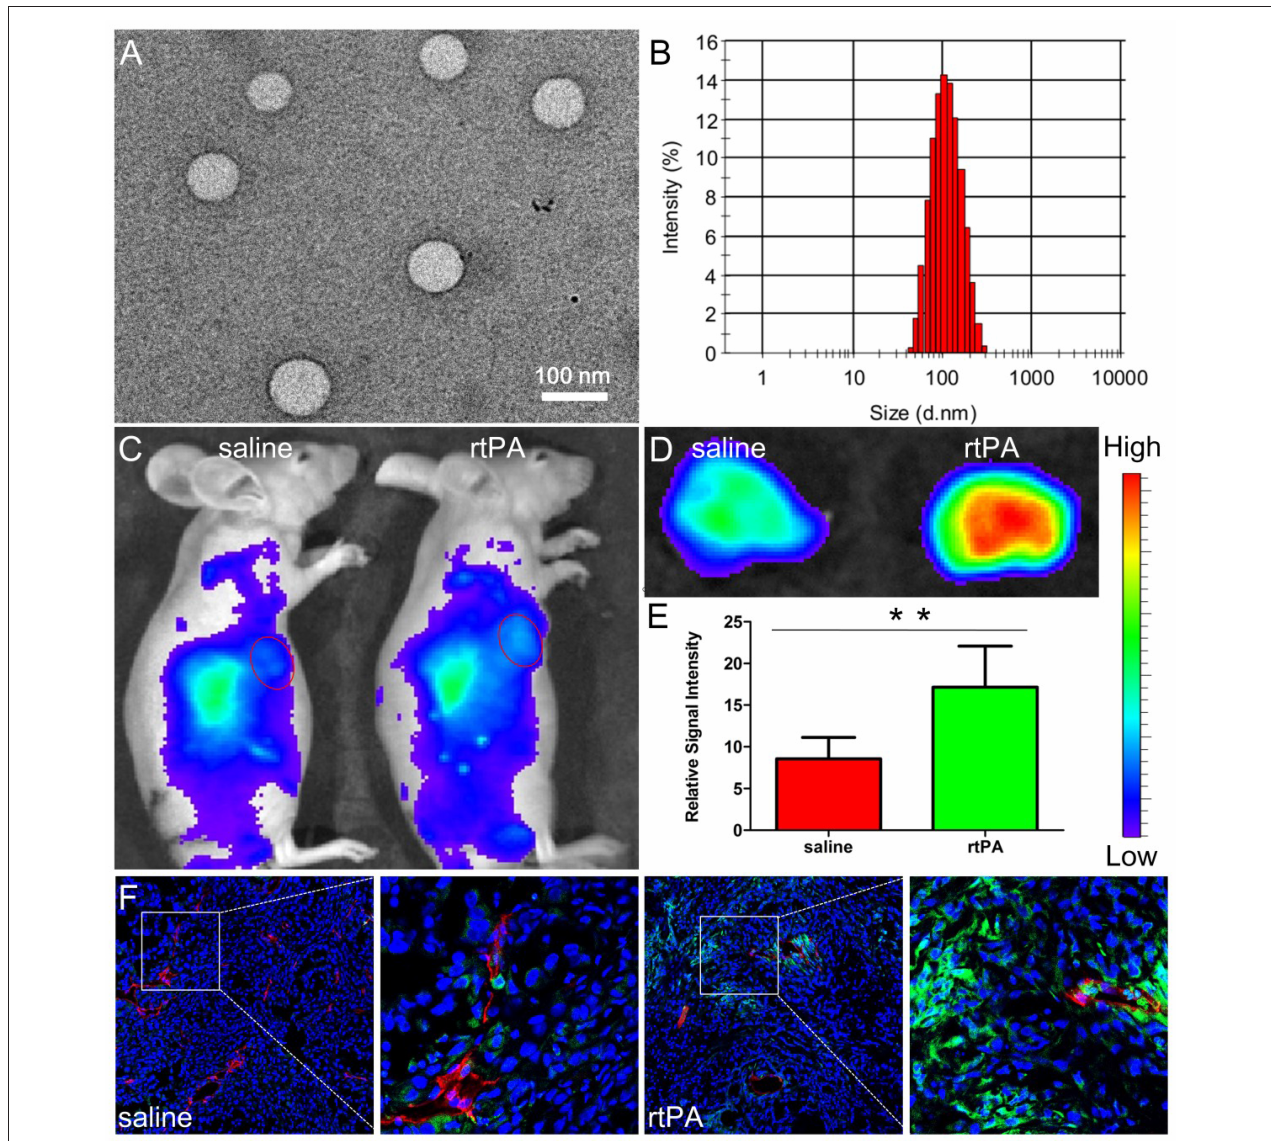
FIGURE 3 | Characterizations of NPs and effects of rtPA treatment on tumor nanoparticle delivery. TEM photograph (A) and size distribution (B) of NPs. Bar: 100nm. In vivo (C) and ex vivo imaging (D,E) of A549 xenograft-bearing mice treated with 2 weeks of rtPA (25 mg/kg/d) or saline 24h after the injection of DiR-labeled NPs. ** p < 0.01 rtPA vs. saline group. In vivo distribution of NPs in tumor tissues. (F) Original magnification: 120 × . Reprinted from reference with permission, Copyright Elsevier,